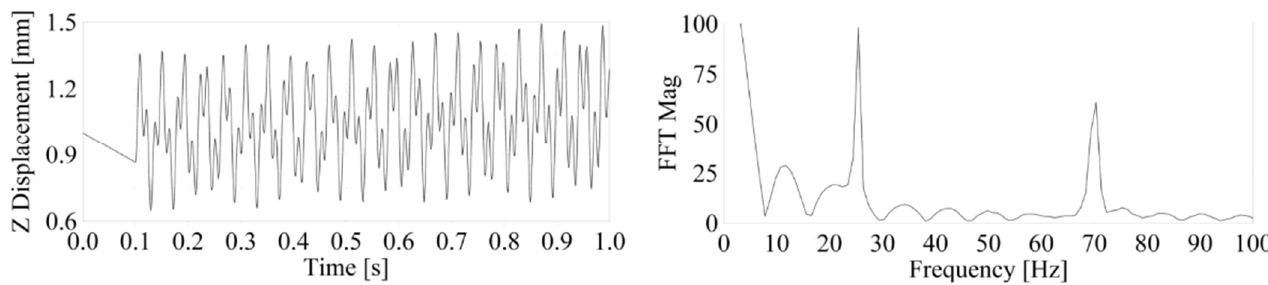
Figure 6. Nonlinear FE model time response ( left ) and time-to-frequency domain conversion of FFT response ( right ), at 25 Hz.